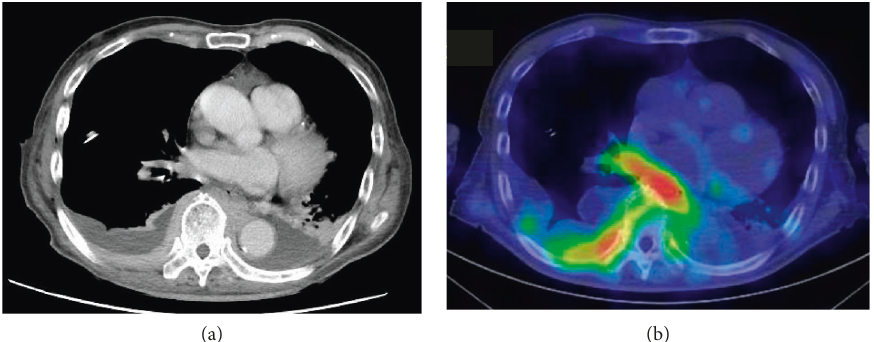
Figure 2: Image of pleural lymphoma. (a) Enhanced computed tomography. (b) Gallium scintigraphy.